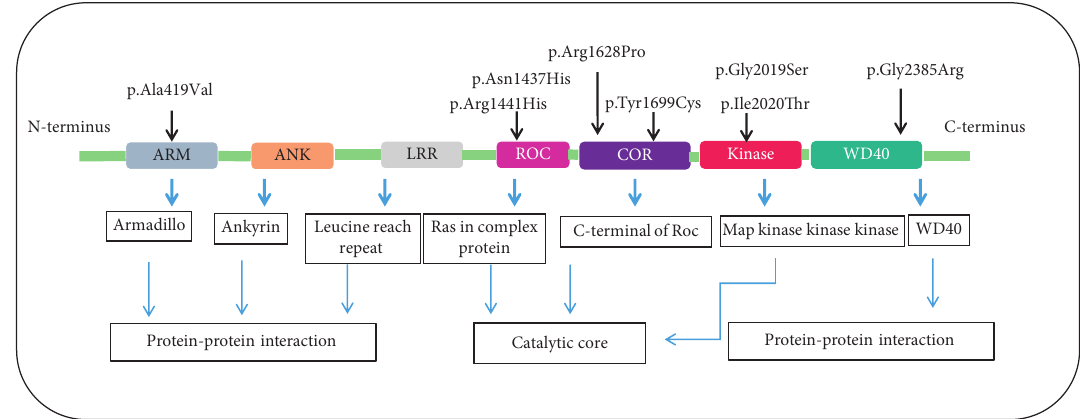
Figure 1: LRRK2 protein: functional domain and the localization of 8 variants. ANK-ankyrin repeat; ARM-armadillo; LRR-leucine-rich repeat; ROC-Ras of complex proteins: GTPase; COR-C-terminal of ROC; WD40-WD-40 domain. Pathogenic mutations are highlighted in blue, and East Asian disease-associated variants are highlighted in